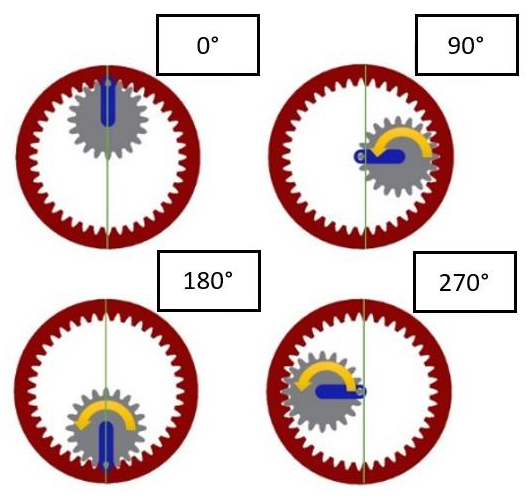
Fig. 2. Principle of operation of hypocycloid